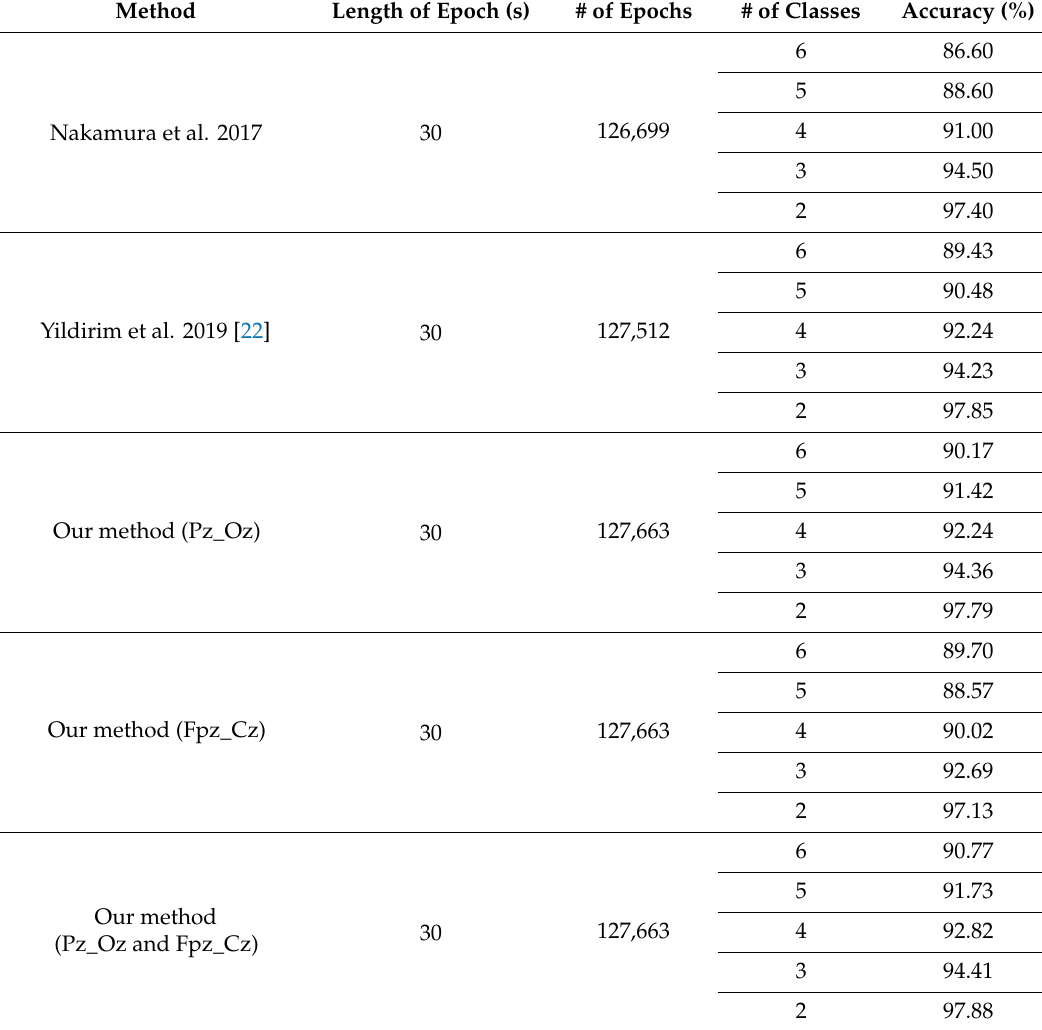
Table 3. Performance comparison on Sleep-EDF dataset (R & K criteria, 2–6